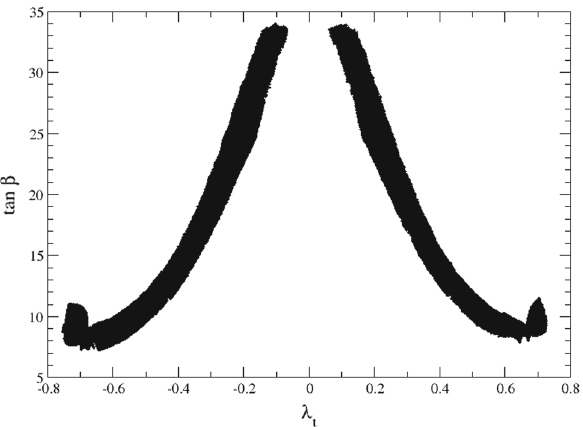
Fig. 4 Correlation of tan β and λ t for points with m ˜ g < 2 . 5 TeV and < 10 4 cm displayed in Figs. 2 and c τ QN 1